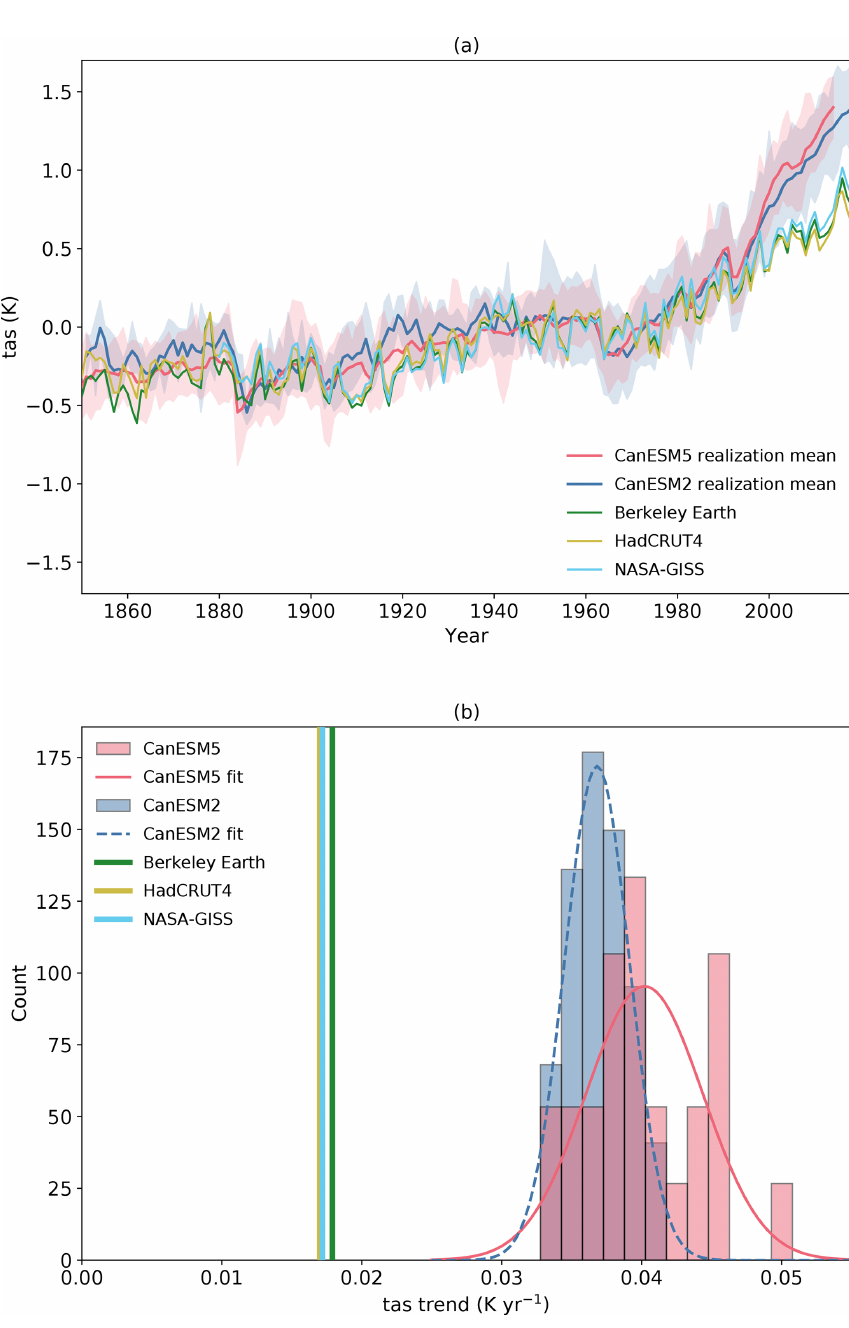
Figure 25. (a) Global-mean screen temperature in CanESM5, CanESM2, and various observational products and (b) histogram of historical trends over 1981 to 2014. In panel (a) , the shaded envelopes represent the range over the CanESM2 50-member large ensemble and the CanESM5 25-member “p1” ensemble. In panel (b) , fits of the normal distribution to the CanESM2 and CanESM5 distributions are also